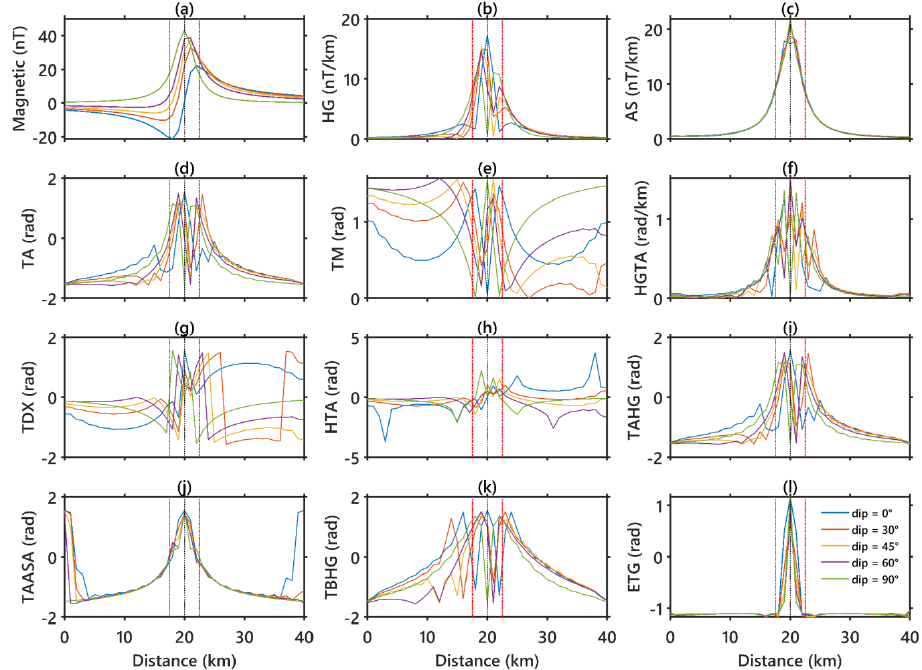
Figure 2. ( a ) The magnetic anomaly response of the dipping dyke models at different dip angles. The